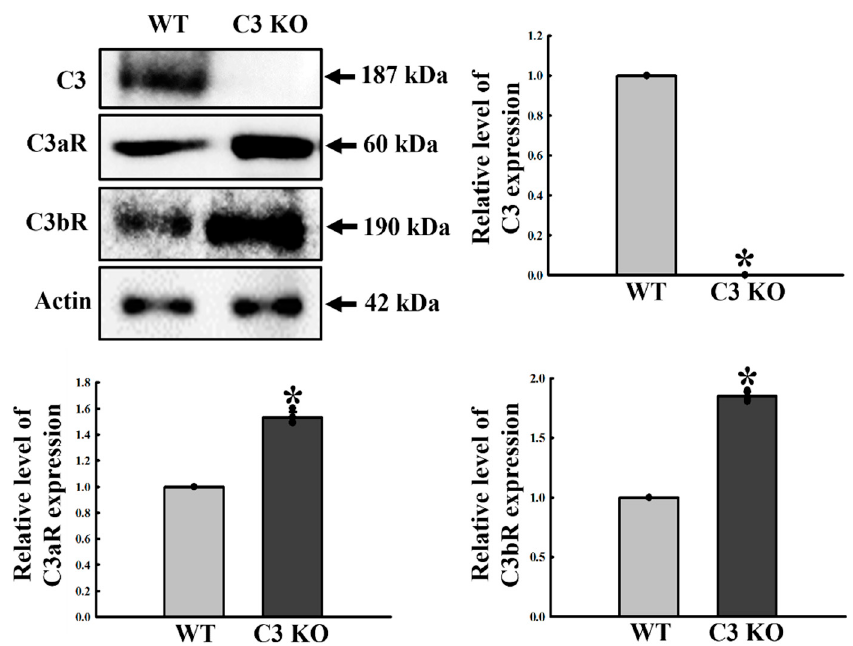
Figure 8. Expression of C3aR and C3bR proteins in the mid colon of C3 KO mice. The expression levels of the C3, C3aR, and C3bR proteins in the mid colon were measured by Western blot analysis using the anti-C3aR and anti-C3bR antibodies. After determining the intensity of each band using an imaging densitometer, the relative levels of the C3, C3aR, and C3bR protein were calculated on the basis of the intensity of β -actin. Four mice per group were used to prepare the tissue lysates, and Western blots were assayed in duplicate for each sample. Data are reported as the mean ± SD. * p < 0.05 compared to the WT group. Abbreviations: WT, wildtype; KO, knockout; C3aR, C3a receptor; C3bR, C3b receptor; HRP, horseradish peroxidase; IgG, immunoglobulin G.